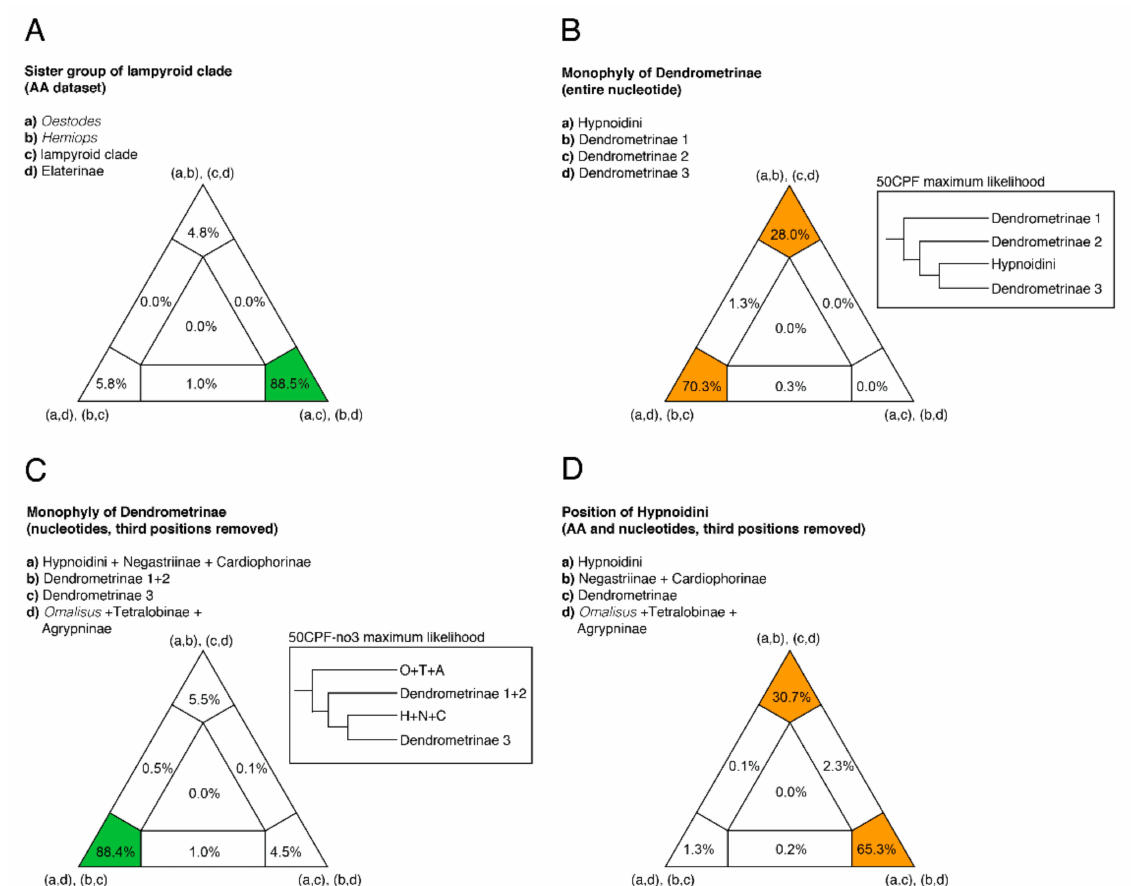
Figure 4. Four cluster likelihood mapping (FcLM) tests of alternative phylogenetic hypotheses: ( A ) the position of the lampyroid clade; ( B ) monophyly of Dendrometrinae, with taxon sets as resolved by concatenated analysis of entire nucleotide dataset (inset phylogeny); ( C ) monophyly of Dendrometrinae, with taxon sets as resolved by concatenated analysis of nucleotide dataset, third positions removed (inset phylogeny); ( D ) the position of Hypnoidini, monophyly of remaining Dendrometrinae assumed (results of AA dataset shown, nucleotide dataset with third positions removed nearly identical). Dendrometrinae 1 = Prosternon Latreille, 1834, Anostirus Thomson, 1859, and Pseudanostirus Dolin, 1964; Dendrometrinae 2 = Oxynopterus Hope, 1842, Plastocerus , and Dimini; Dendrometrinae 3 = Selatosomus , Ctenicera , Semiotus , and Dendrometrini; O + T + A = Omalisus + Tetralobinae + Agrypninae; H + N + C = Hypnoidini + Negastriinae +